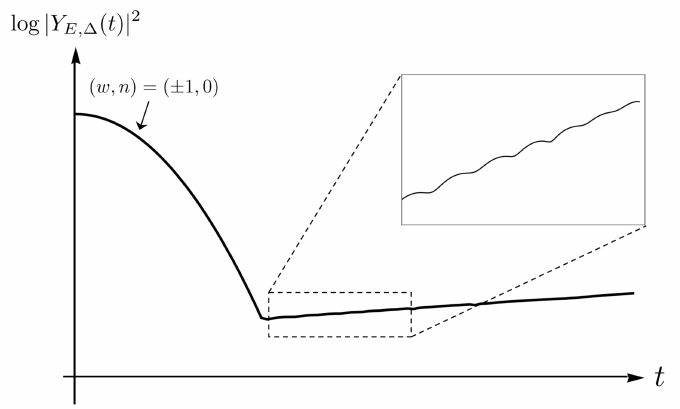
Figure 3 . The spectral form factor for a free string gas with high energy. The usual winding mode with w = ± 1 and no momentum (in bosonic or Type II theories) gives the early decay. If we zoom in into the latter part, we see bumps and each can be identified with some other winding